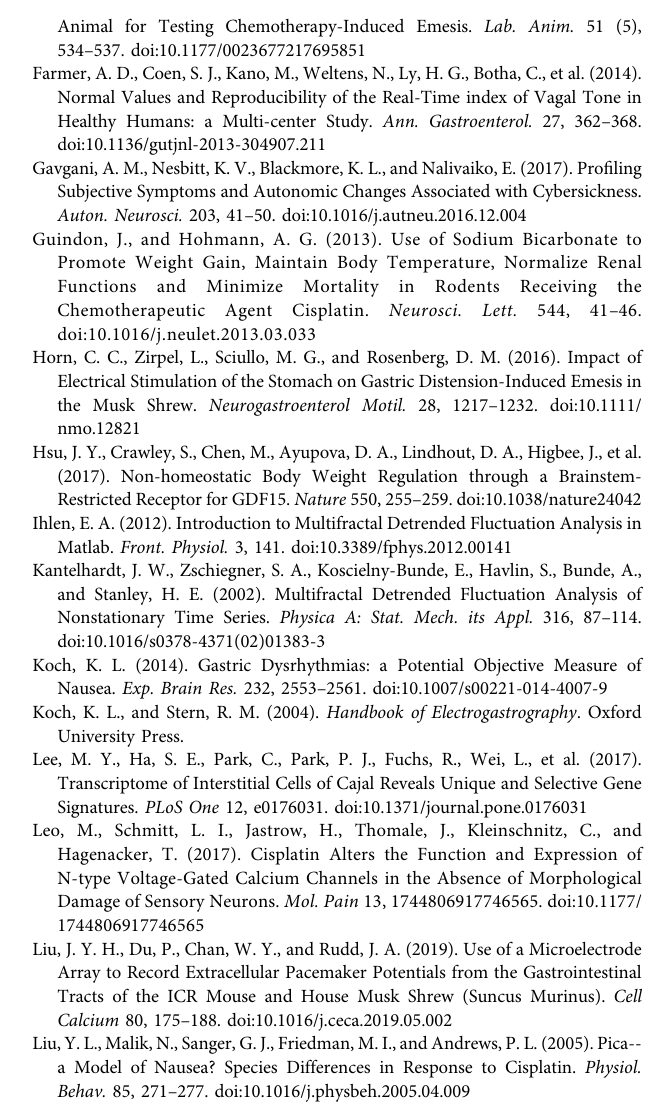
Supplementary Figure 1 | Representative raw trace of pacemaker potentials at baseline (black)and duringcisplatin (1 – 10 μ M; redor blue)treatment. Red andblue lines represent data showing an increase or decrease in the dominant frequency, respectively.